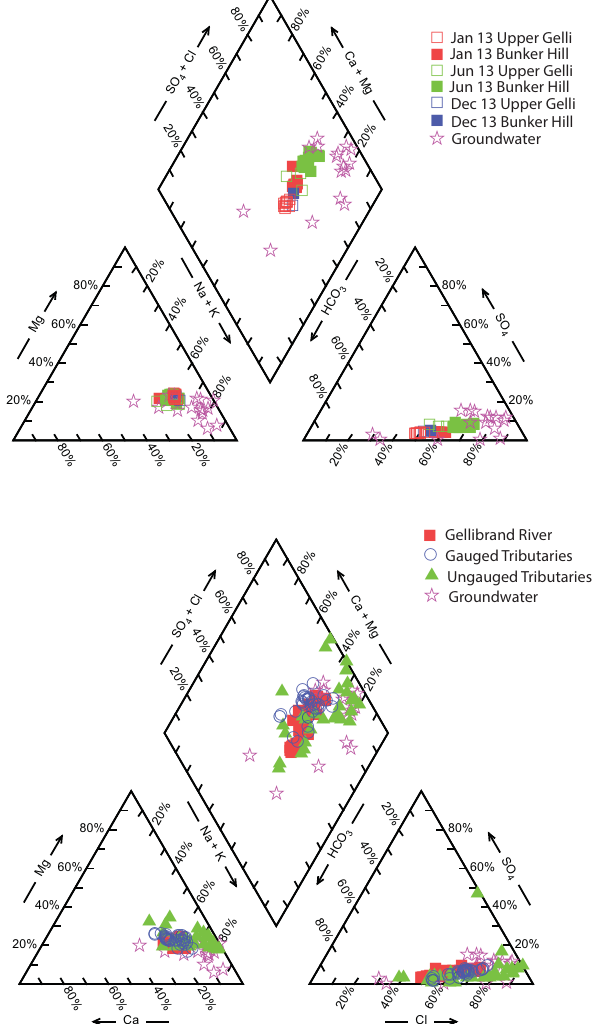
Figure 3. Piper diagrams showing temporal and spatial patterns in the chemistry of streamflow and groundwater. The top panel shows seasonal variations in the composition of flow in the Gel- librand River at the upstream (Upper Gellibrand) and downstream (Bunker Hill) sites over three sampling trips. The data in the upper plot show compositional change from upstream to downstream and also from summer to winter towards the general groundwater com- position. The lower panel shows compositional differences across all sampling trips between the Gellibrand River, gauged tributaries, ungauged tributaries and